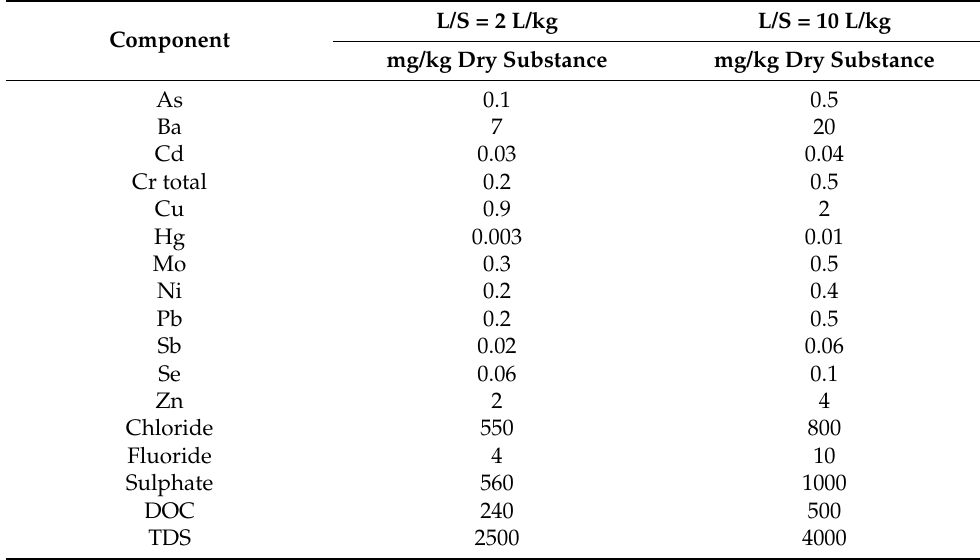
Table 3. Leaching limit values for inert waste acceptable at landfills